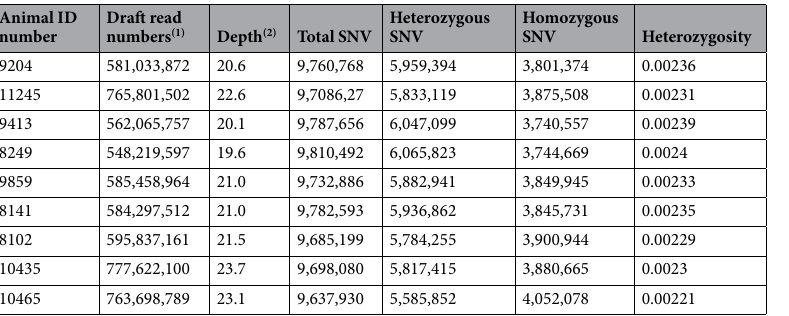
Table 1. General results of whole genome sequencing of nine animals. (1) Average read length 100 bp. (2) Reads mapped on